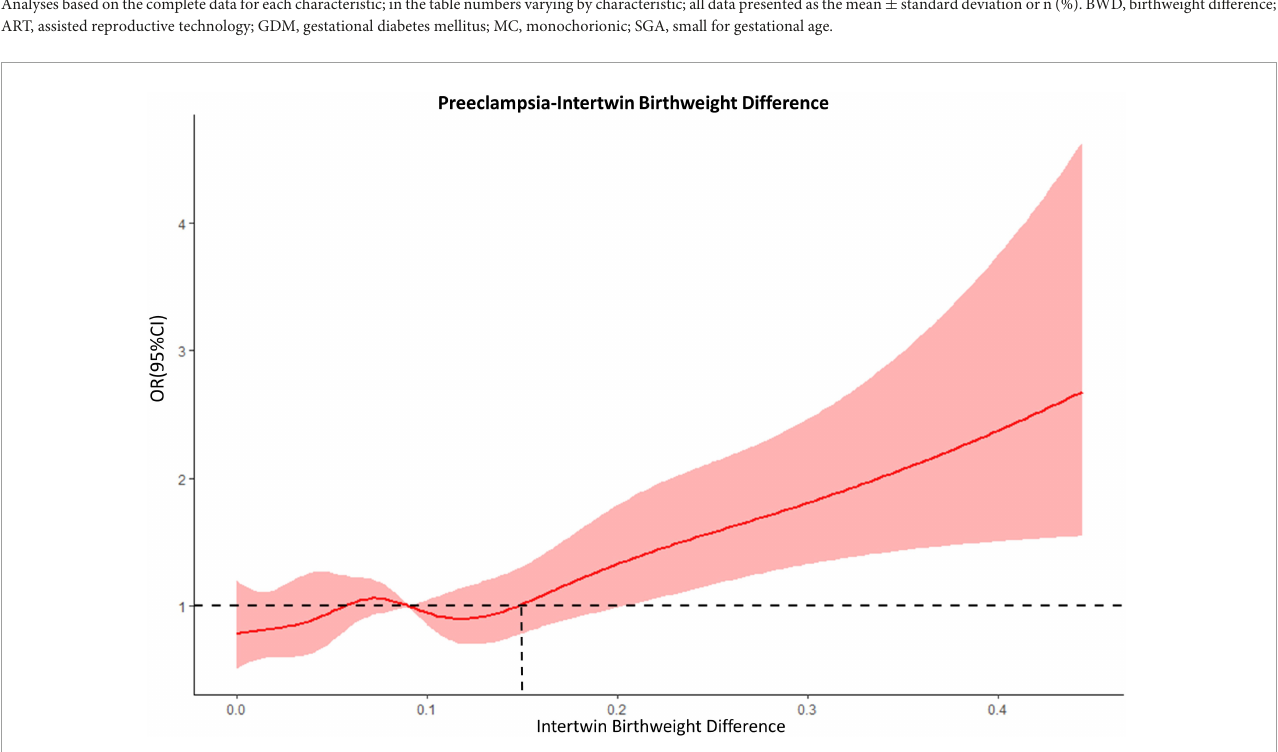
the association of the intertwin BWD with preeclampsia. P